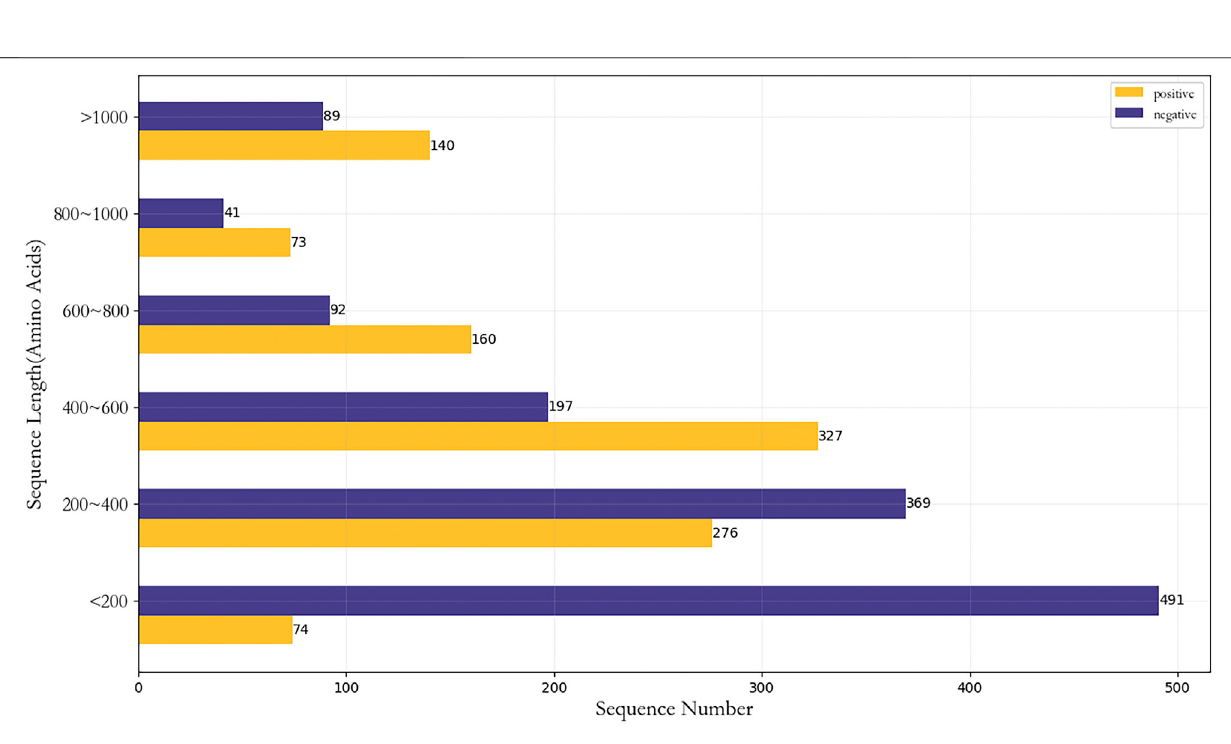
FIGURE 2 | Sample distribution of